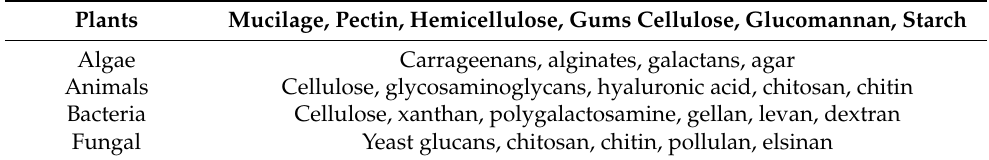
Table 2. Classification of polysaccharides according to their origin [90].